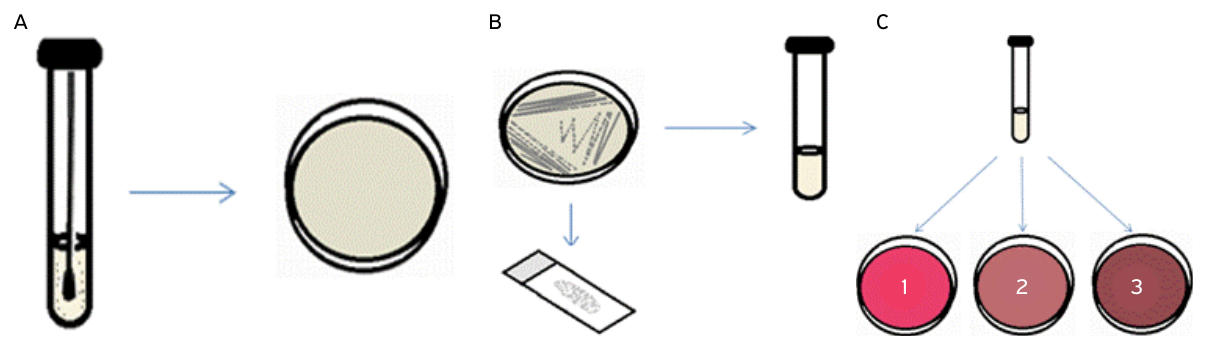
Figura 3. Esquema ilustrativo dos procedimentos realizados: (A) primeira fase do experimento: tubo de coleta com swab e posterior semeadura em TSA; (B) segunda fase do experimento: identificação e isolamento dos grupos gram e transferência, para enriquecimento em Caldo Triptona de Soja; (C) terceira fase do experimento: após enriquecimento, a semeadura em meios seletivos 1) Manitol, 2) SS e 3)